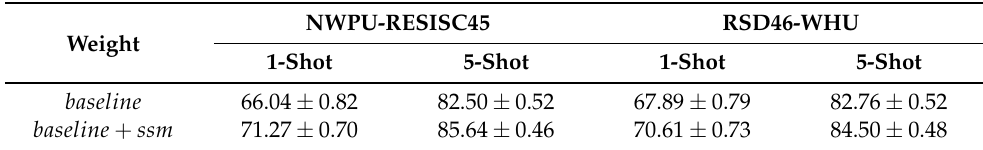
Table 4. Comparison results with baseline on 5-way few-shot